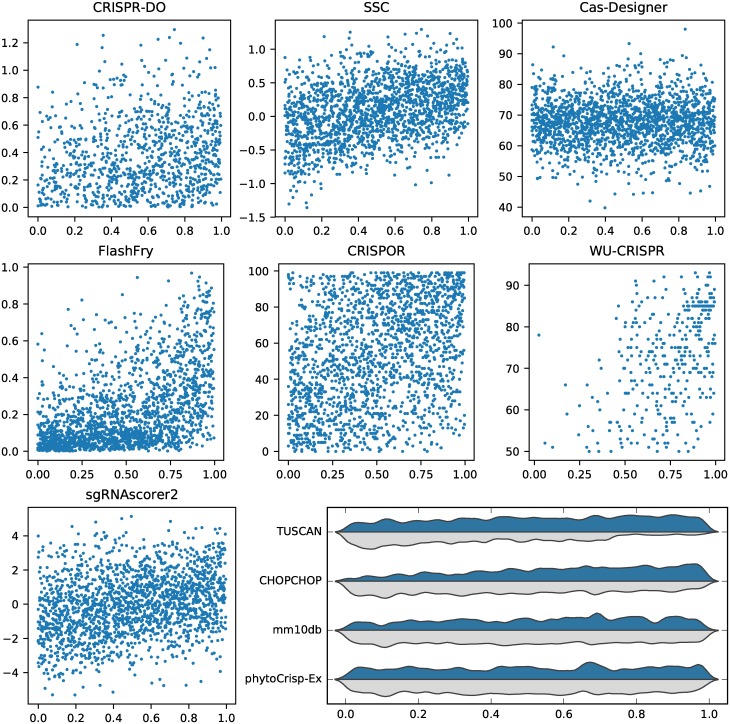
Tool performance on Doench guides.For tools that score guides, the experimental gene rank score versus score reported by tool is plotted. For TUSCAN, mm10db, CHOPCHOP and phytoCRISP-Ex, the distribution of accepted and rejected guides is shown, based on their associated gene rank score.